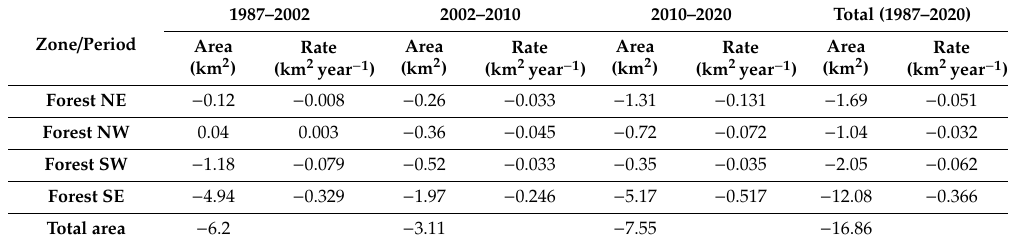
Figure 7. The spatial change of forest extent in Bumbu basin in the years ( a ) 1987, ( b ) 2002, ( c ) 2010, and ( d ) 2020. Table 5. Observed forest area gain and loss and the gain–loss rate in four forest